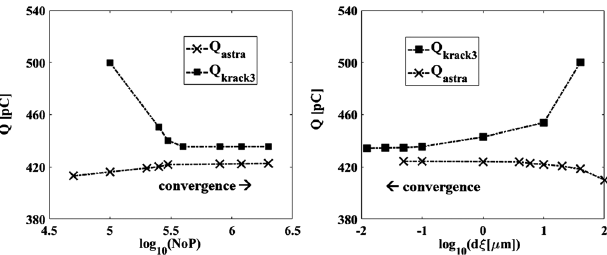
FIG. 13. Illustration of convergence studies summarized in Table II (left) and Table III (right).